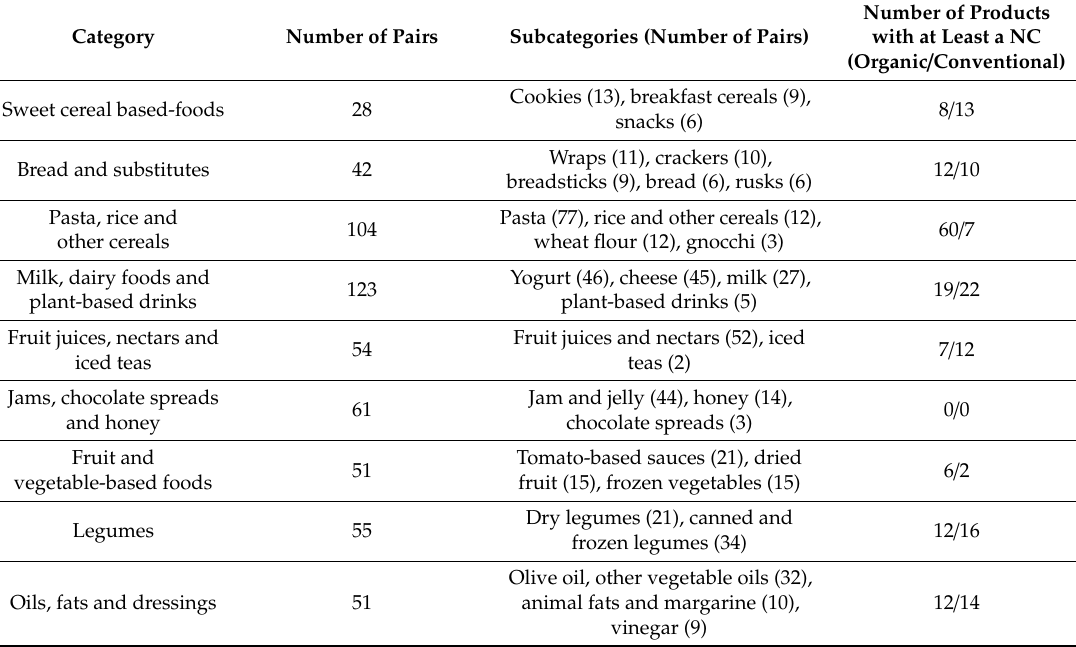
Table 1. Categories, total number of pairs, subcategories of products considered within each category and number of organic and conventional products with at least a Nutrition Claim